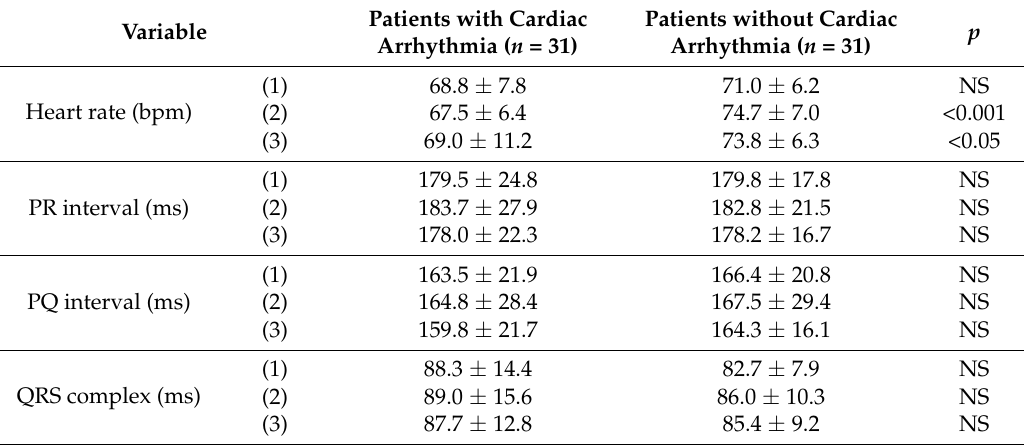
Table 3. Results of electrocardiogram (ECG) parameters in overactive bladder (OAB) patients during the